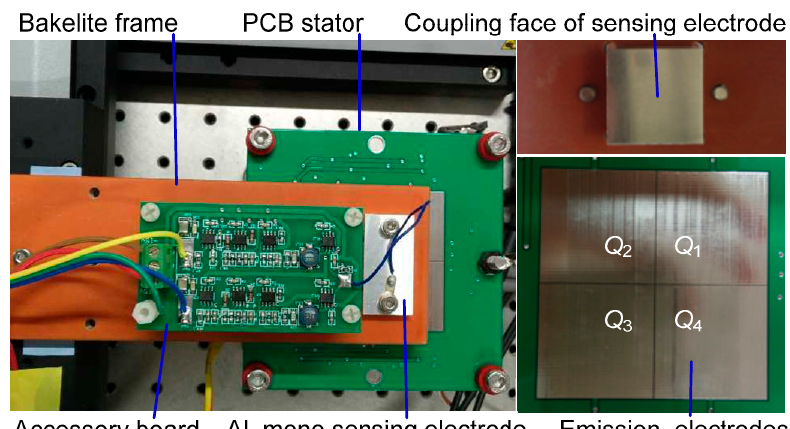
Figure 4. Photograph of PCB sensor prototype.